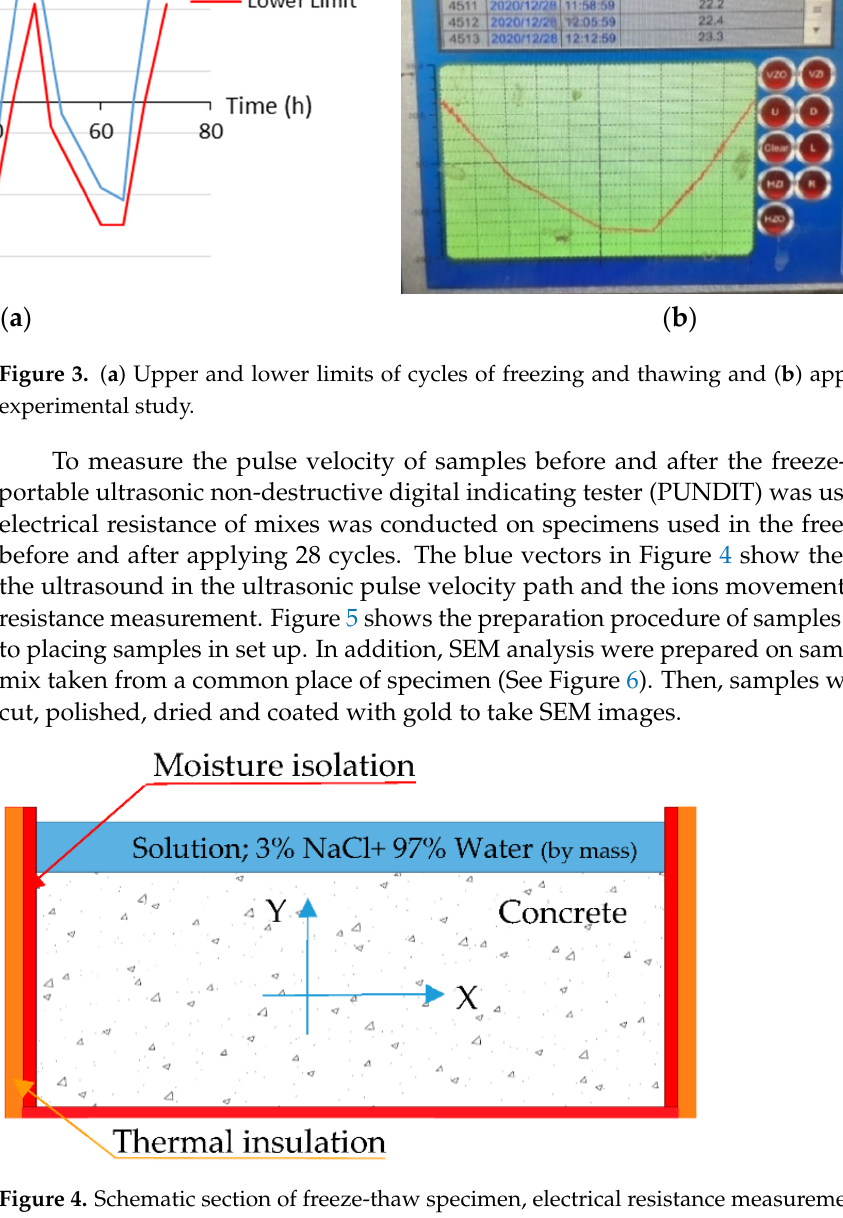
Figure 3. ( a ) Upper and lower limits of cycles of freezing and thawing and ( b ) applied cycles in